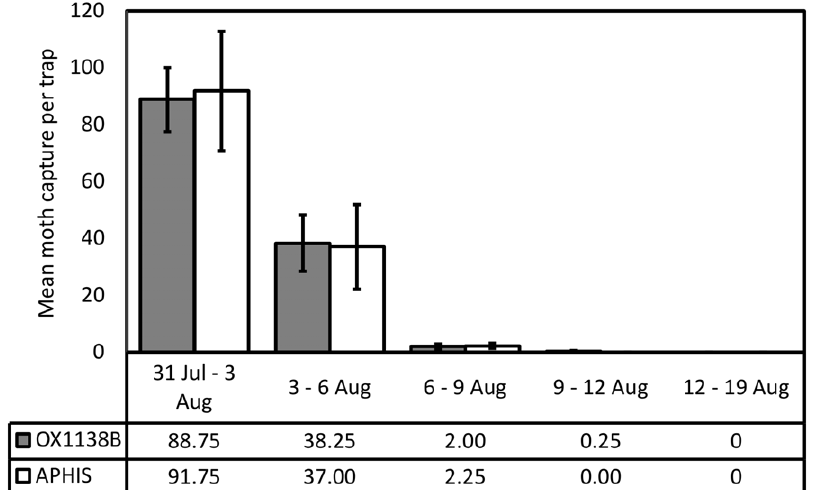
Figure 7. Moth persistence after end of release period. Trapping continued beyond the last release date of 1 August 2007, to assess the rate of decline of OX1138B and APHIS populations when no longer supplemented by additional releases. Mean number of moths caught within field 1 per trap are shown by date. Filled bars=OX1138B, white bars=APHIS moths; error bars indicate Standard Error of Mean. No significant difference in persistence between the strains was found ( x 2 =1.46, df=1; p=0.23).